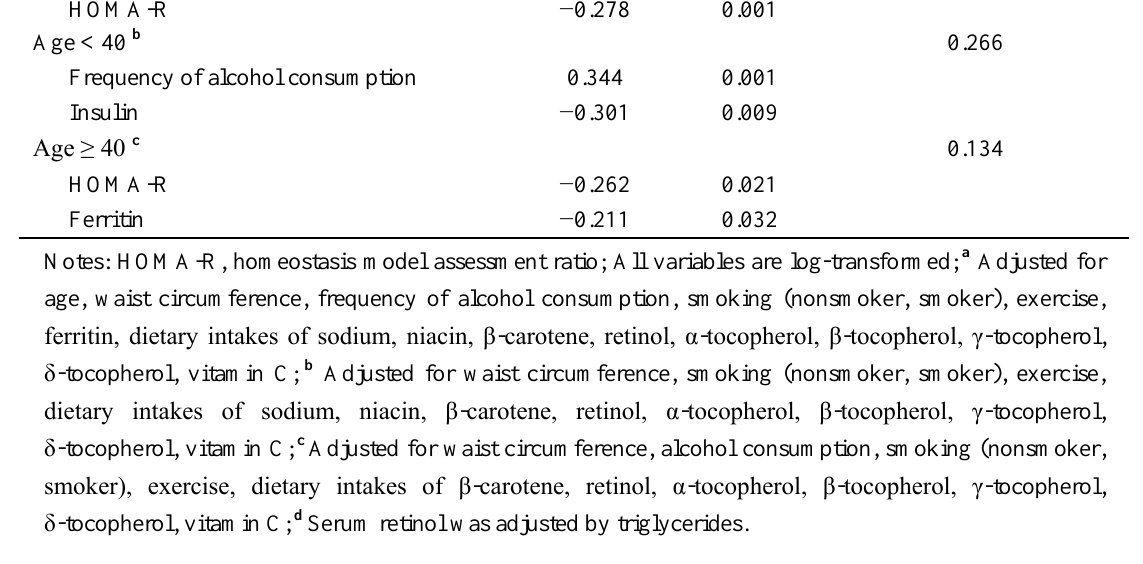
Table 5 . Multiple regression analysis of serum α-tocopherol with each